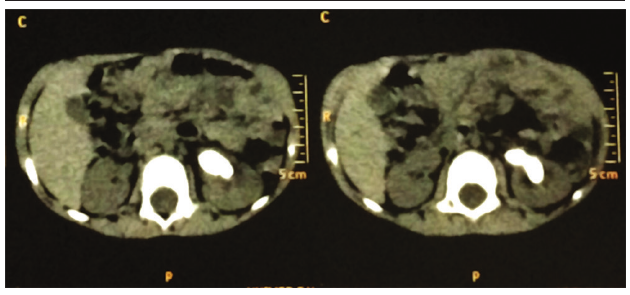
figurE 3 − CT scan of abdomen and pelvis showing hyperintense mass in the left kidney CT: computed tomography.